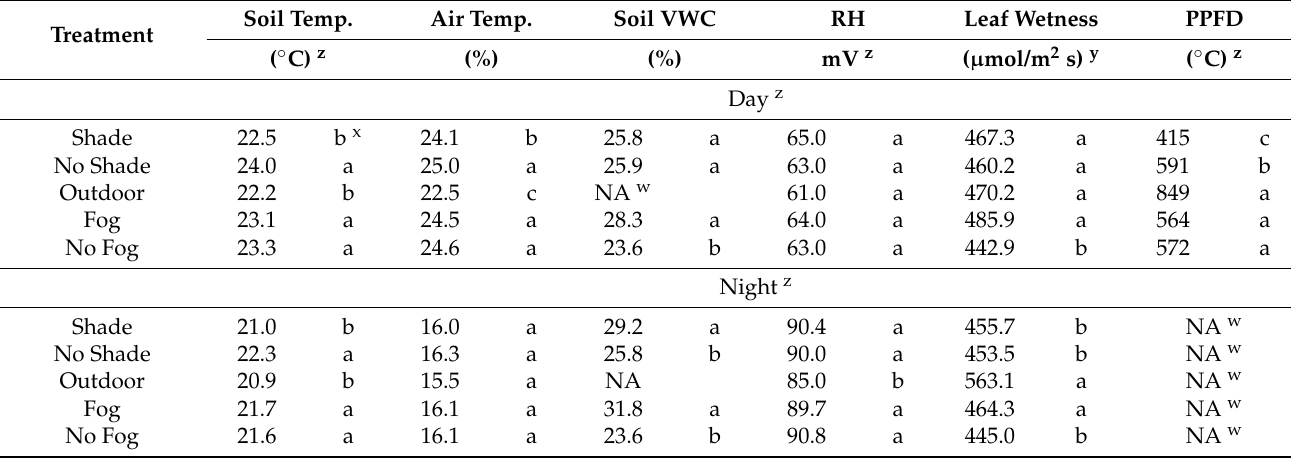
Table 1. Day and night soil volumetric water content (VWC) and temperature, air temperature, relative humidity (RH), leaf wetness, and photosynthetic photon flux density (PPFD) in high tunnels with shade or fogging. Soil Temp. Air Temp. Treatment